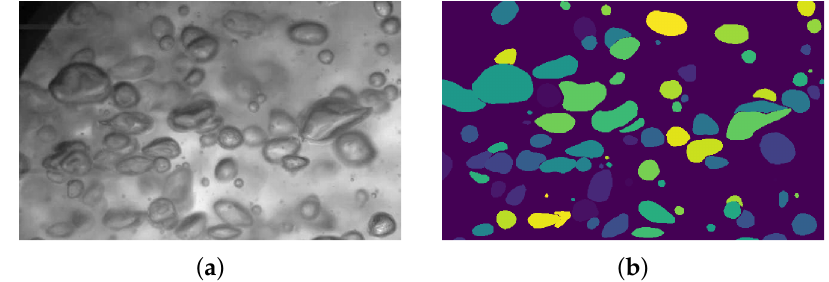
Figure 28. Training image ( a ) and mask ( b ) samples for the StarDist method.